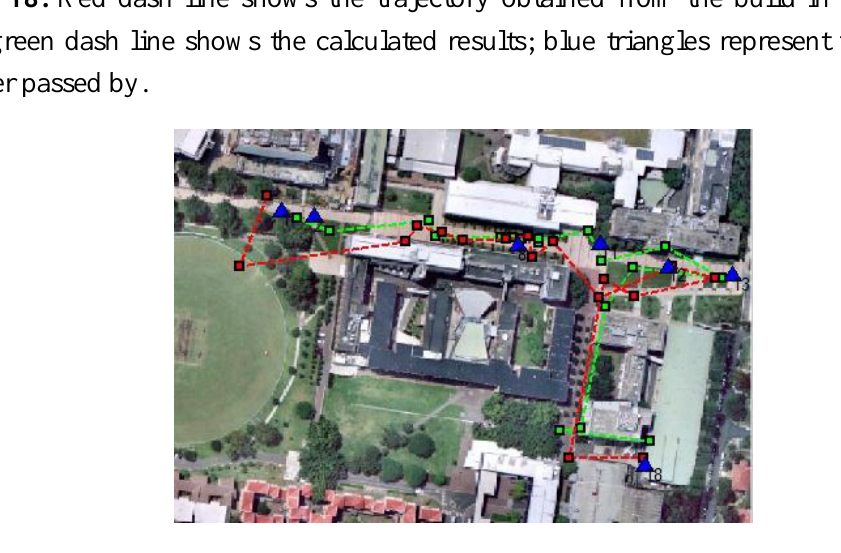
Figure 19. Height: blue icons represent true values; red ones are altitude measured by the device; green ones indicate the calculated